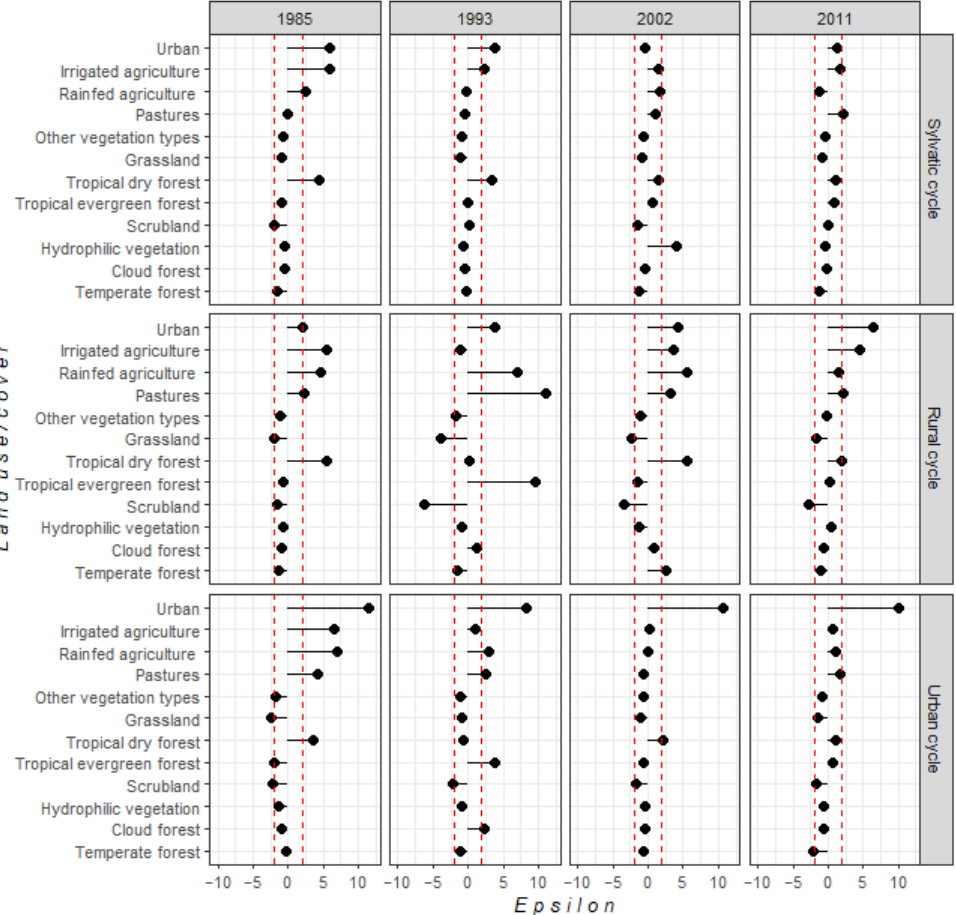
Figure 1. Statistical relationship between each land-use/cover class and each T. cruzi cycle, based on ε -values. The red dotted line indicates confidence intervals of statistically significant correlation (i.e., | ε | >